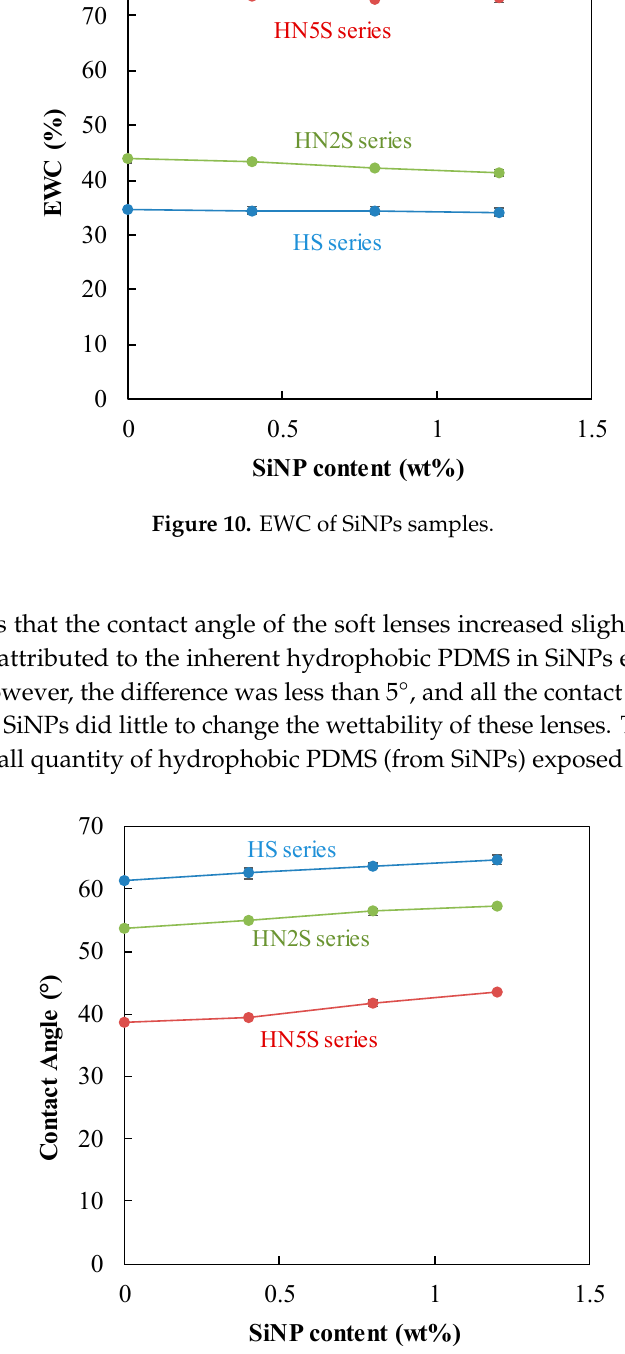
Figure 12. The FTIR spectra of HS- series SiNPs-containing contact lenses.